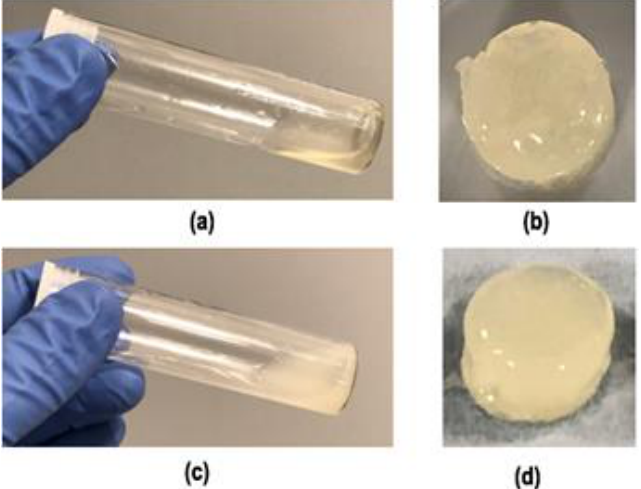
Figure1. Imagesofthefinalhomogeneoussolutions( a )transparentCI(CS,5%( w / v )initialconcentration) Figure 1. Images of the final homogeneous solutions ( a ) transparent CI (CS, 5% ( w / v ) initial and ( c ) composite sol, SI: CS-0.1HA-0.005Hep (solutions were obtained after neutralising with NaHCO 3 concentration) and ( c ) composite sol, SI: CS-0.1HA-0.005Hep (solutions were obtained after and 2 mL of the solution was taken into a glass-tube (75 mm × 18 mm) with three level push polythene neutralising with NaHCO 3 and 2 mL of the solution was taken into a glass-tube (75 mm × 18 mm) plug cap) and hydrogels of ( b ) CI and ( d ) SI acquired after heat treatment in one level open plug cap of the tube at 37 ◦ C-oven for 48